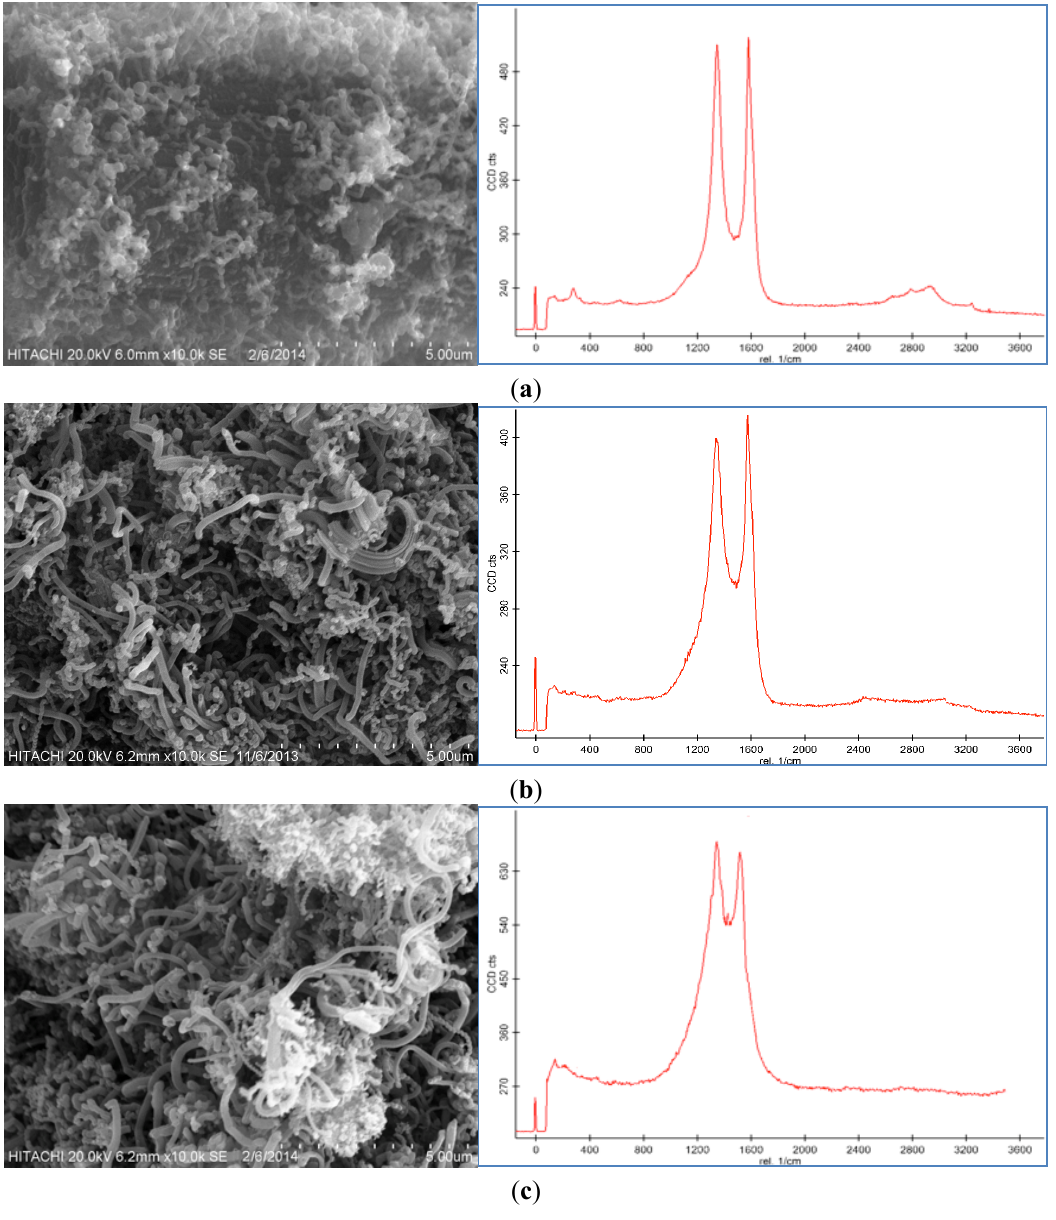
Figure 6. SEM images and Raman spectroscopy of carbon nanofiber on CF by use of 100 mM catalyst concentration at 550 °C for 30 min at ( a ) 25 sccm, ( b ) 50 sccm, and ( c ) 100 sccm flow rate of C 2 H 2 .